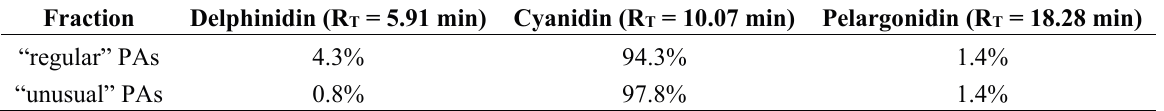
Table 1. Estimation of mono-, di-, and trihydroxylated anthocyanidins.